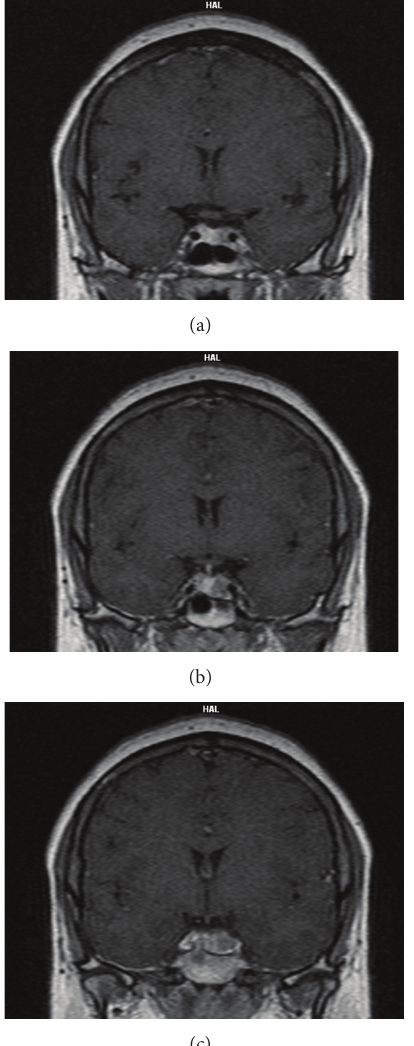
F 2: Postcontrast T1 weighted MRI aer 1 year of